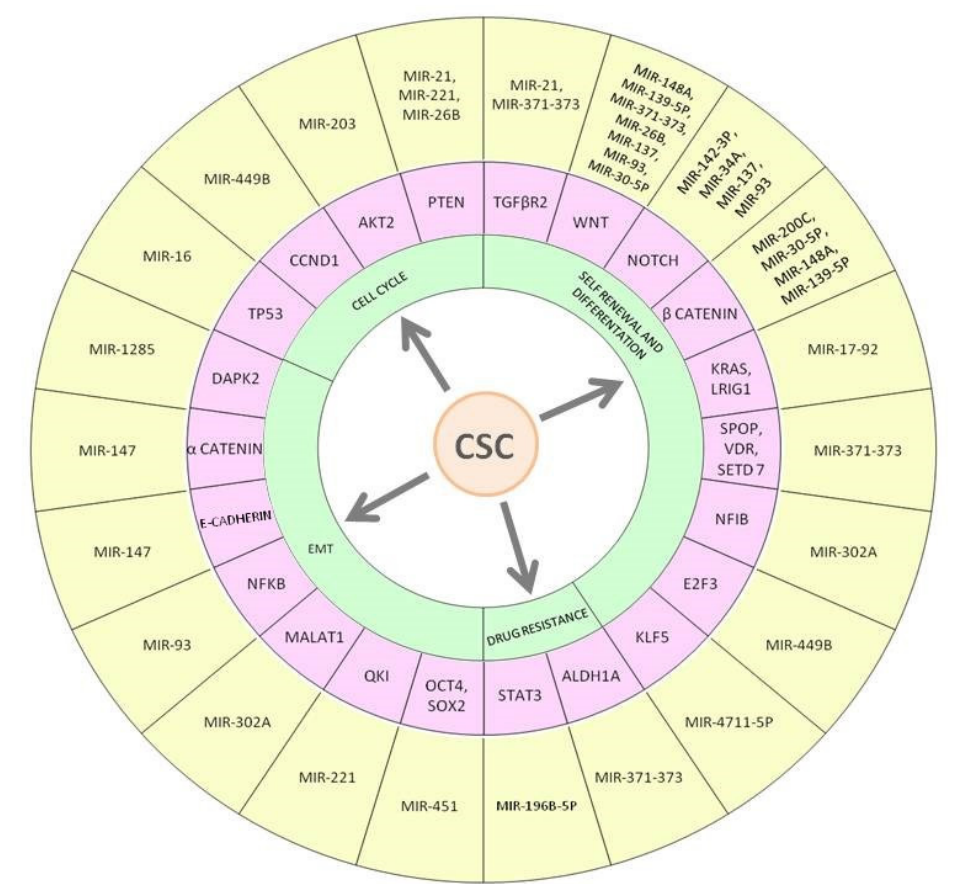
Figure 3. Main miRNAs regulating colorectal cancer stem cell features. The figure shows miRNAs-mRNA interactions that may reduce or promote the development and features of CCSC, such as cell cycle, self-renewal and differentiation, EMT process, and drug resistance linked to the initiation and progression of CRC. MiR-21 is an oncomiR that promotes CCSCs development by interacting with PTEN and TGF β R2. A regulatory loop has been identified between miR-16 and TP53, its deregulation in CCR favors development of CCSCs.